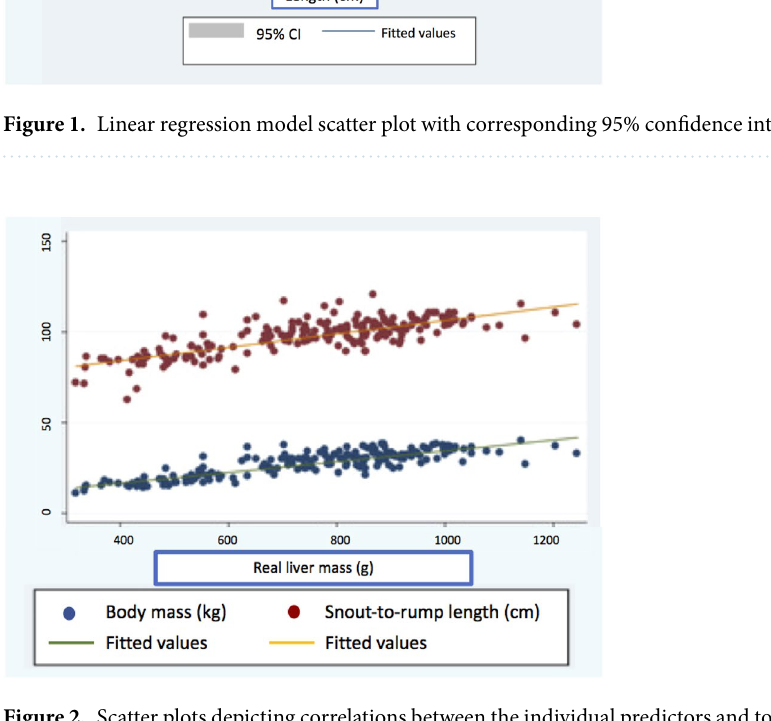
Figure 2. Scatter plots depicting correlations between the individual predictors and total liver mass.